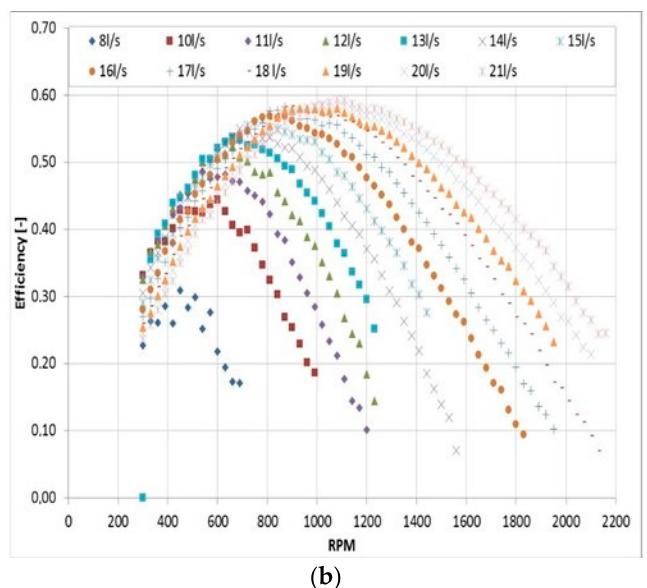
Figure 7. Experimental results. ( a ) Head; ( b ) Efficiency.